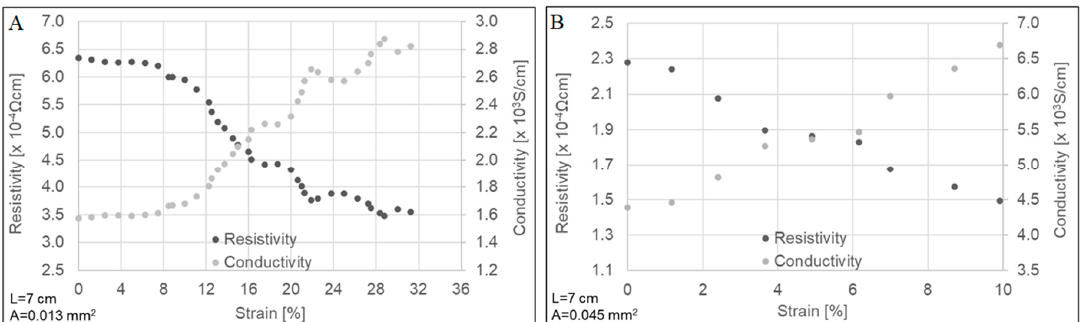
Figure 2. Electrical properties as a function of strain for untreated CNTYs ( A ) and post-treated CNTYs ( B ). L and A represent the yarn’s length between the electrodes and the average cross-sectional area of the yarn, respectively.